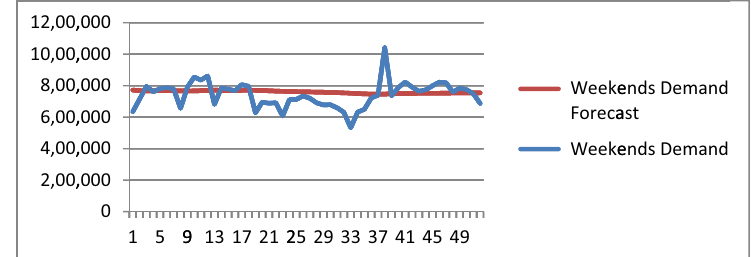
Figure 5: Values obtained as a result of simple average method with test values for weekends.